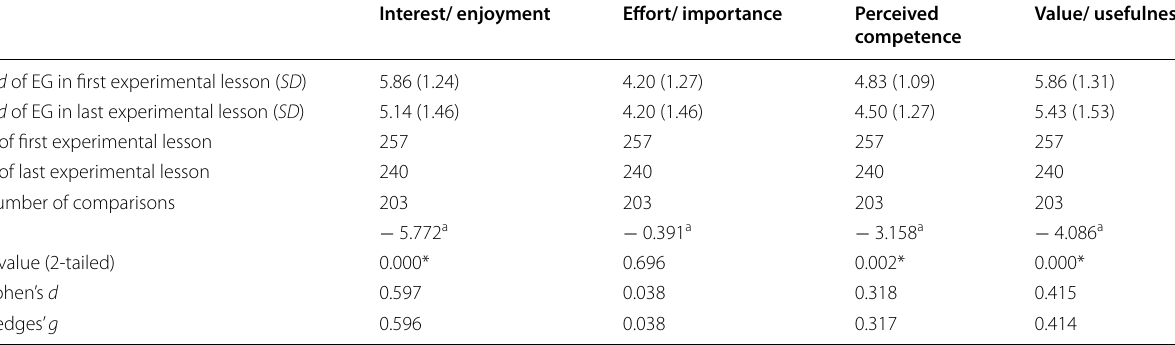
Table 4 Change in the students’ intrinsic motivation in the EG between the first experimental lesson (Post-Questionnaire 2_1) and the experimental lesson after three months of intensive use of 3D models and animations in the educational process (Post-Questionnaire